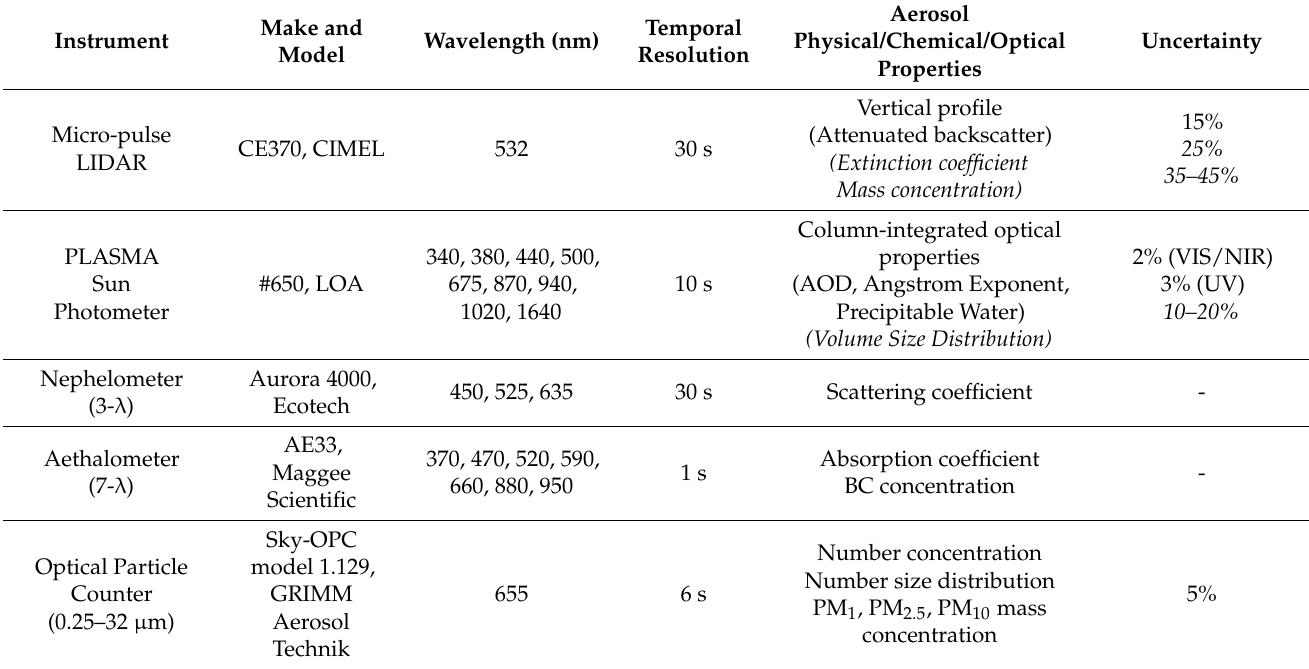
Figure 1. ( a ) Area investigated by the mobile measurements during the MOABAI campaign (blue) and the North China Plain (red), ( b ) GPS track of all mobile transects and ( c ) IAP instrumented van used for the mobile observations. Table 1. Instruments set up in the IAP mobile laboratory during the MOABAI campaign. The aerosol properties in italic were derived from measurements using inversion